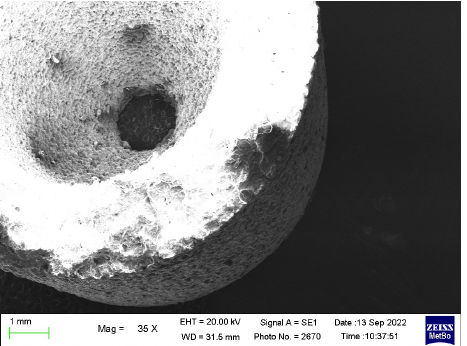
Figure 3. Test specimen with microshot-peened external surface.